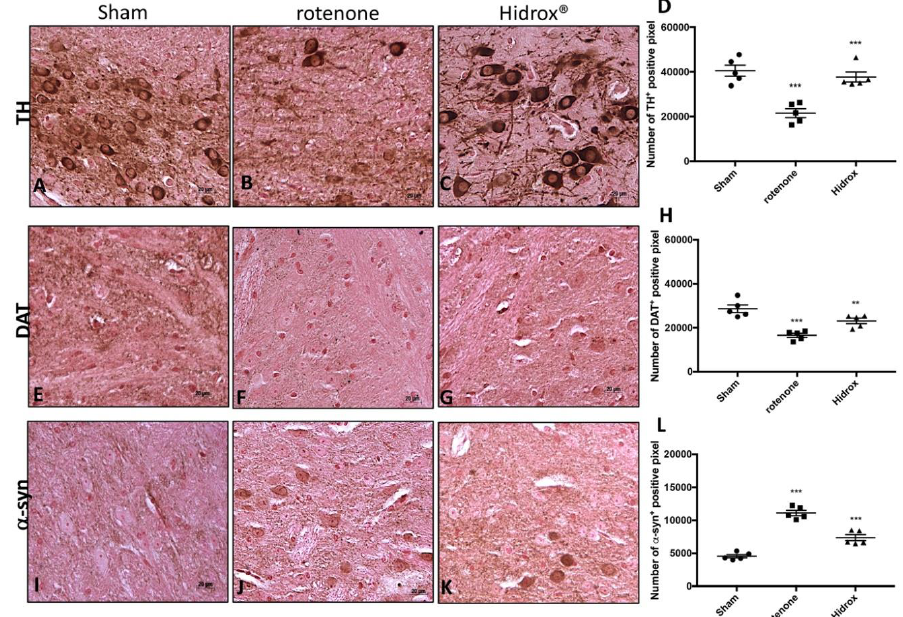
Figure 2. E ff ects of HD on TH, DAT and α -synuclein expression in SN of rotenone-treated mice. The immunohistochemical analysis has shown, compared with the Sham mice ( A ), a noticeable loss of TH-positive cells ( B ). Animals treated with HD revealed an increase in TH expression ( C ). *** p < 0.001 vs. Sham; *** p < 0.001 vs. rotenone ( D ). The immunohistochemical analysis revealed, compared with Sham group ( E ), an evident loss of DAT-positive cells ( F ). Animals subjected to treatment with HD revealed a positive stain for DAT ( G ) compared with rotenone group. *** p < 0.001 vs. Sham; ** p < 0.01 vs. rotenone ( H ). The midbrain was marked with antibodies against α –synuclein aggregation ( I – K ). The immunohistochemical analysis revealed, compared with Sham animals ( I ), a positive staining for α -synuclein ( J ). HD treatment appreciably reduced the positive staining for α -synuclein in the SN ( K ). *** p < 0.001 vs. Sham; *** p < 0.001 vs. rotenone ( L ). Data are expressed as the % of TH-positive pixels and are the means ± SEM of 5 mice / group. Scale bar: 20 µ